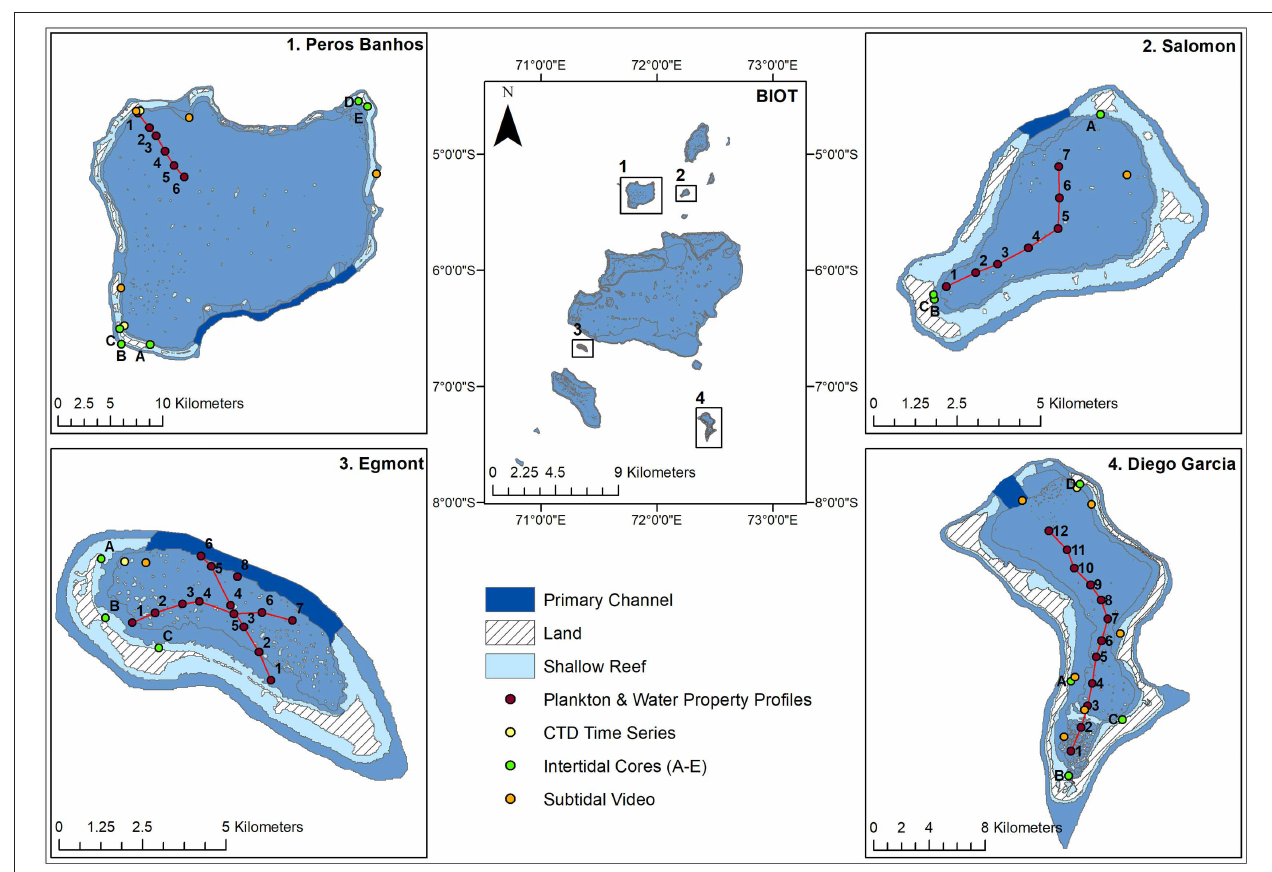
FIGURE 1 | Map of BIOT with sampled atolls and their primary channels. Transects of plankton and water property profiles are shown, alongside CTD time series, intertidal cores, and subtidal